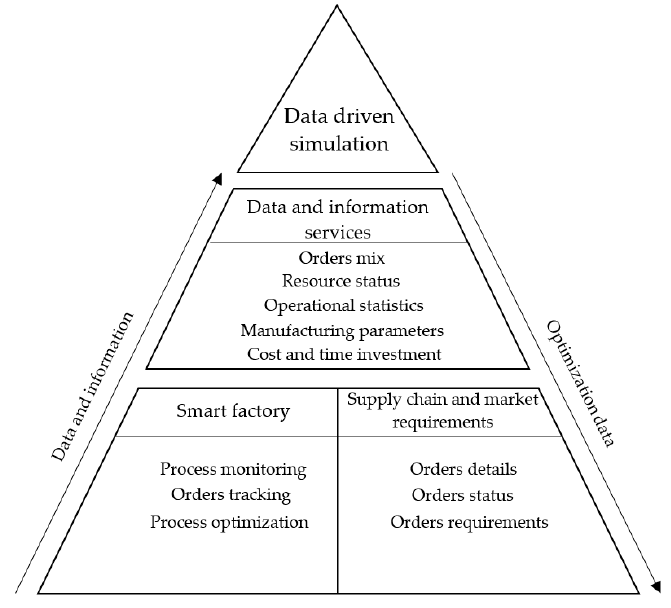
Figure 2. Proposed data-driven simulation modeling data transfer.